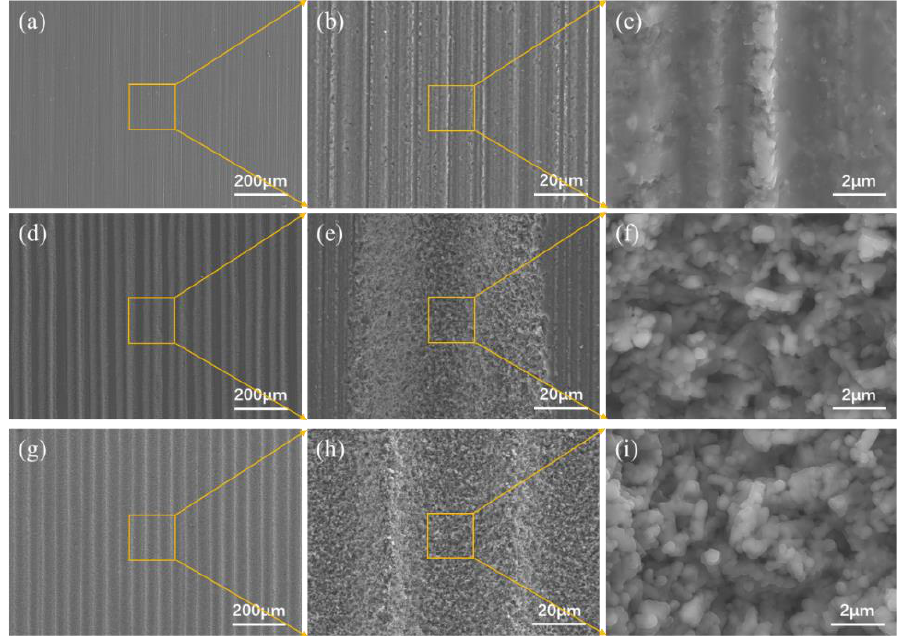
Figure 3. MRLS microstructure of Si 3 N 4 : ( a ) pristine surface; ( b ) groove of pristine surface; ( c ) microstructure and roughness of pristine surface; ( d ) loose surface; ( e ) high magnification of loose surface after laser processing; ( f ) nanoparticles of loose surface; ( g ) dense surface; ( h ) high magnification of dense surface after laser processing; and ( i ) nanoparticles of loose surface.